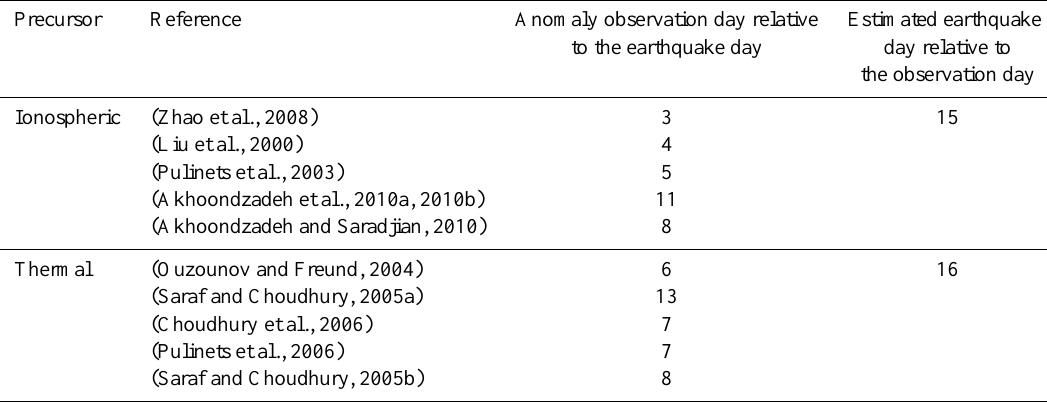
Table 2. Estimation of the earthquake date (Akhoondzadeh, 2011). Precursor